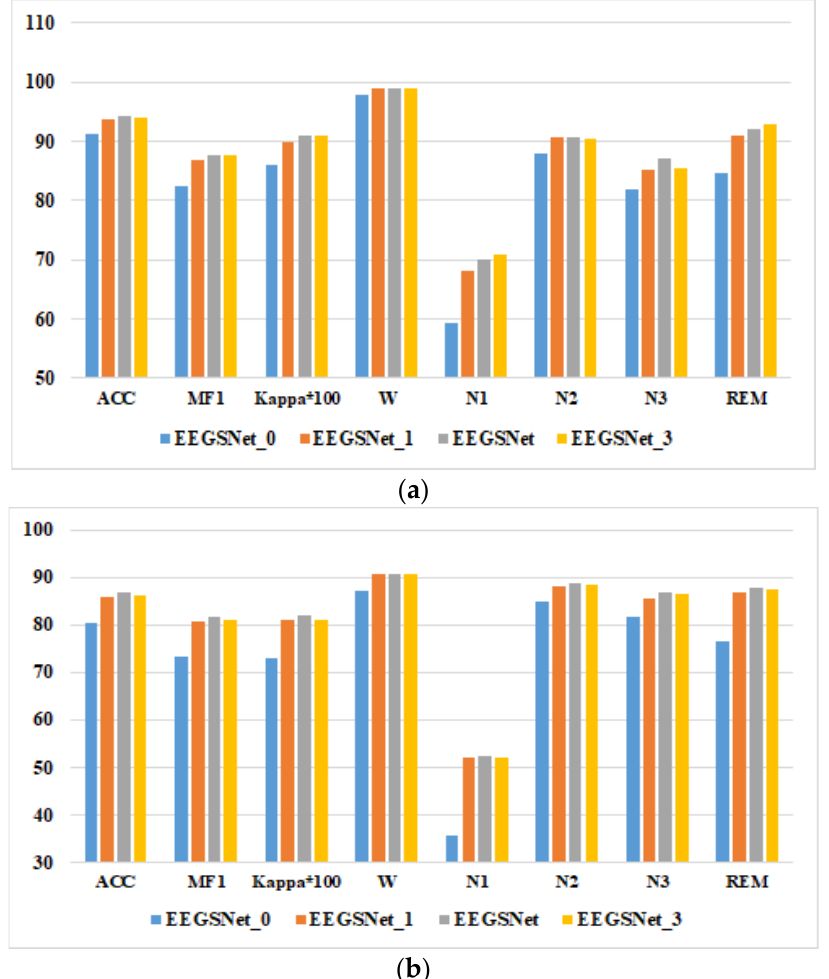
Figure 13. Results of ablation experiments on two datasets: ( a ) Sleep-EDFX-8, ( b ) Sleep-EDFX-20.